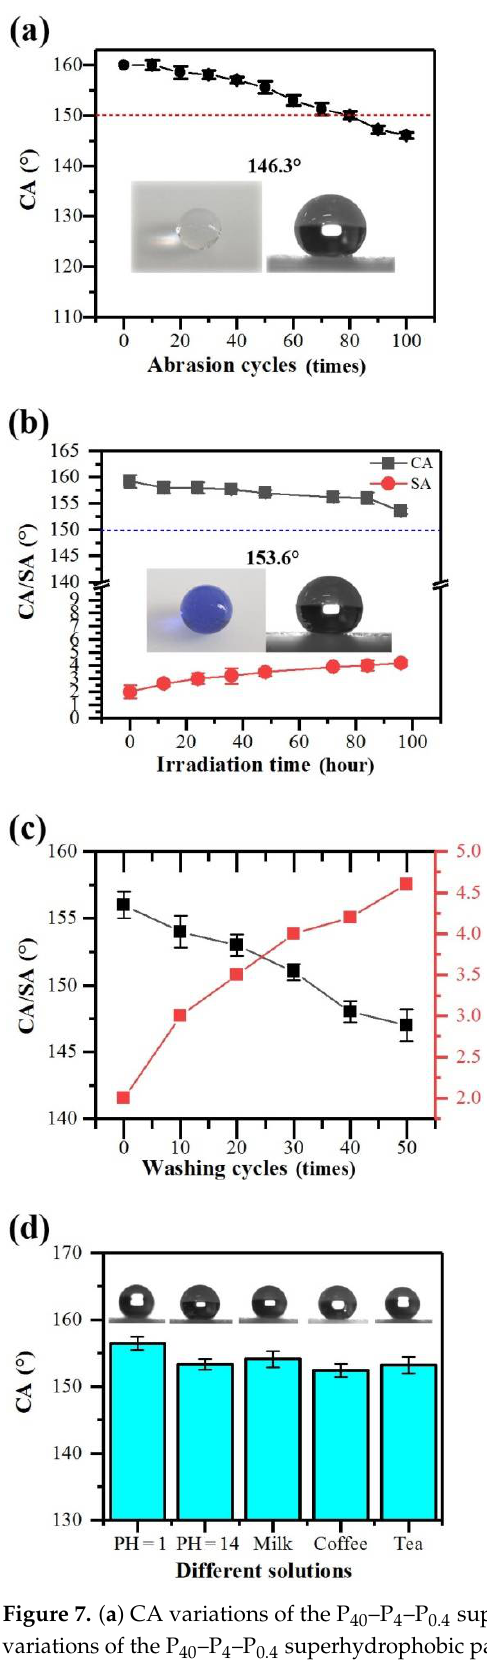
Figure 7. ( a ) CA variations of the P 40 –P 4 –P 0.4 superhydrophobic paper with attrition cycles, ( b ) CA variations of the P 40 –P 4 –P 0.4 superhydrophobic paper with UV irradiation time, ( c ) CA and SA of the P 40 –P 4 –P 0.4 superhydrophobic coating during 0–50 washing cycles, and ( d ) CA of the P 40 –P 4 –P 0.4 superhydrophobic coating soaked in several corrosive solutions. (The inset is a photo of water droplets and contact angle after various treatments).